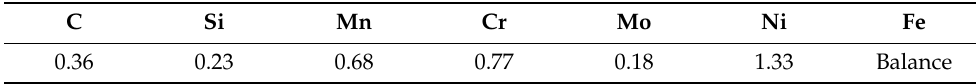
Table 1. Main chemical composition of 40CrNiMo